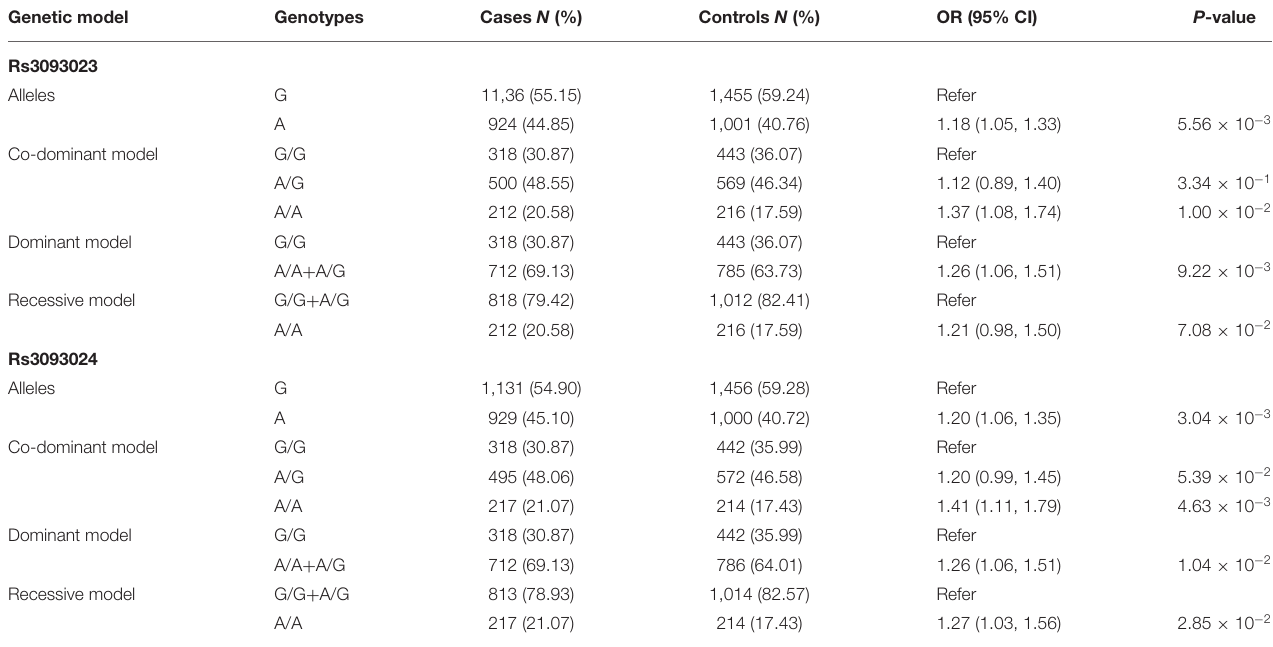
TABLE 2 | Allele and genotype frequencies of rs3093023 and rs3093024 in the replication